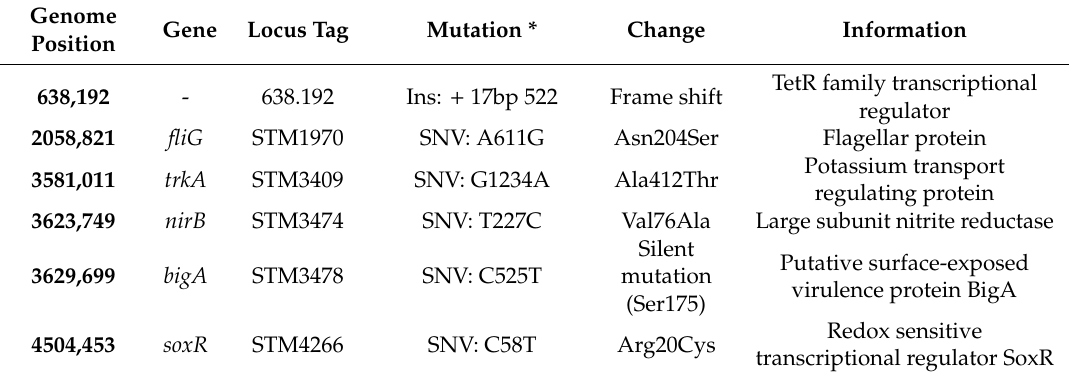
Table 5. Mutations of SeLCar (strain evolved by cyclic exposure to short lethal treatments of carvacrol) in comparison with Salmonella enterica subsp. enterica serovar Typhimurium LT2 wild type